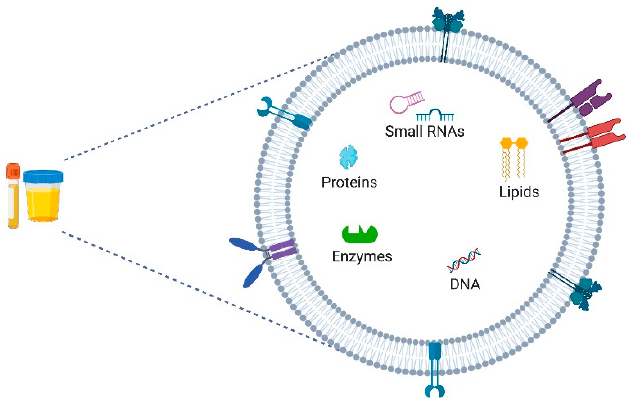
Figure 2. Content and cargo of extracellular vesicles: small RNAs, lipids, proteins, enzymes and DNA. Created with BioRender.com.